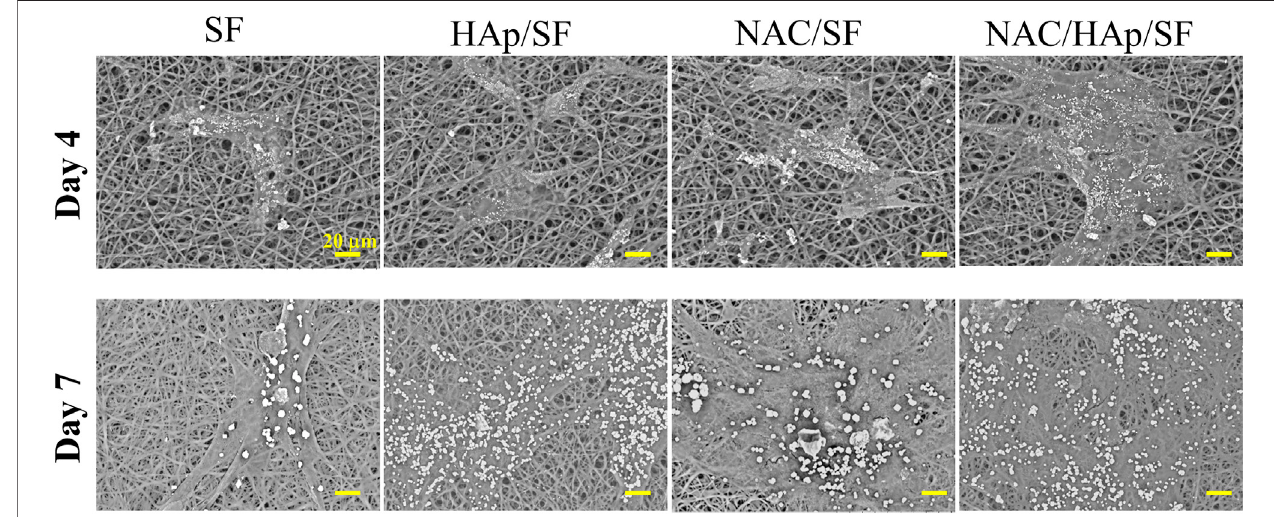
FIGURE 6 | Morphological observation of iPSC-MSCs planted on different composite fi bers for 4 and 7 days, n (cid:1) 3.